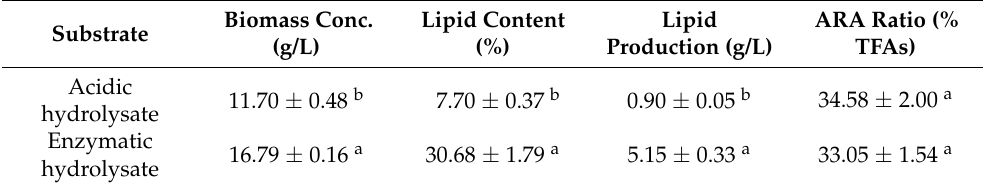
Table 3. Biomass concentration, lipid content, lipid production and ARA ratio of Mortierella alpina FU30797 after 5 days of cultivation with TPW acidic and enzymatic hydrolysate. Biomass Substrate